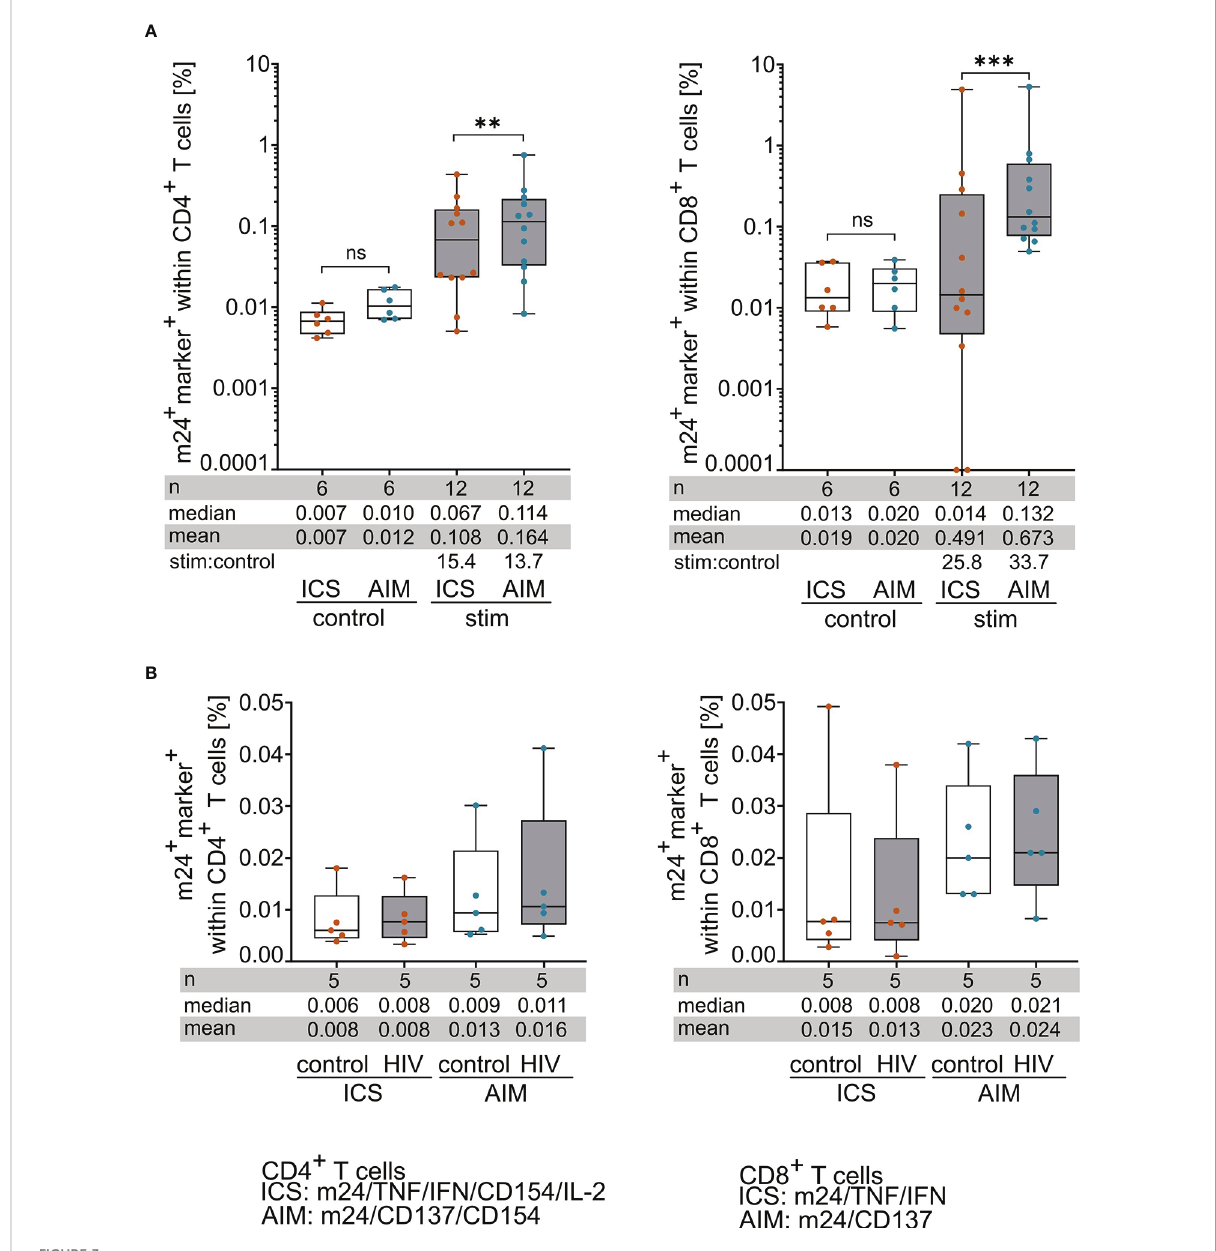
FIGURE 3 m24+AIM staining detects antigen-speci fi c T cells with increased sensitivity compared to m24+ICS. PBMCs were incubated with antigenic peptides or left unstimulated for 14 h in the presence of CD40 Ab (m24+AIM) or brefeldin A and monensin (m24+ICS). Summed frequencies of m24 + and at least one additional marker + T cells after Boolean gating are presented as box and whisker plots showing median, interquartile range, minimum and maximum for control and peptide-stimulated CD4 + (left graphs) and CD8 + (right graphs) T cells detected with m24+ICS or m24+AIM. Number of samples (n), median, mean and stimulated:control ratios (stim:control) are indicated. (A) Comparison of CD4 + (left) and CD8 + (right) T cell frequencies detected with m24+ICS or m24+AIM in unstimulated control and peptide-stimulated tests (n=6 HD, 12 donor/antigen combinations). Frequencies of stimulated samples are background subtracted. Values that were 0 were set to 0.0001. (B) Comparison of CD4 + (left) and CD8 + (right) T cell frequencies detected with m24+ICS or m24+AIM in control or HIV peptide-supplemented samples (n=5 HD). To compare both conditions, HIV tests were not background subtracted. Wilcoxon matched pairs, p<0.05 (** 0.002, *** < 0.001). ns, not signi fi